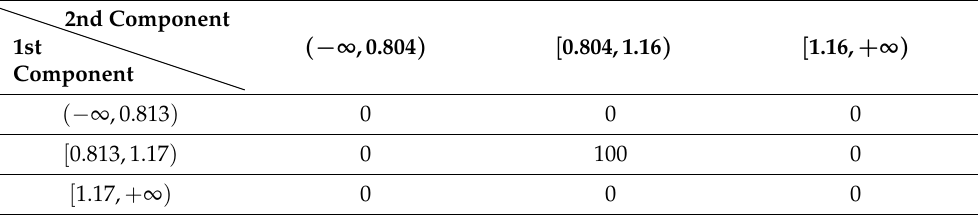
Table 3. Frequency table of the particle distribution over the suggested grid at t = 10 when the particles x i , i = 1, . . . ,100, move only according to the deterministic part of Equation (9). 9